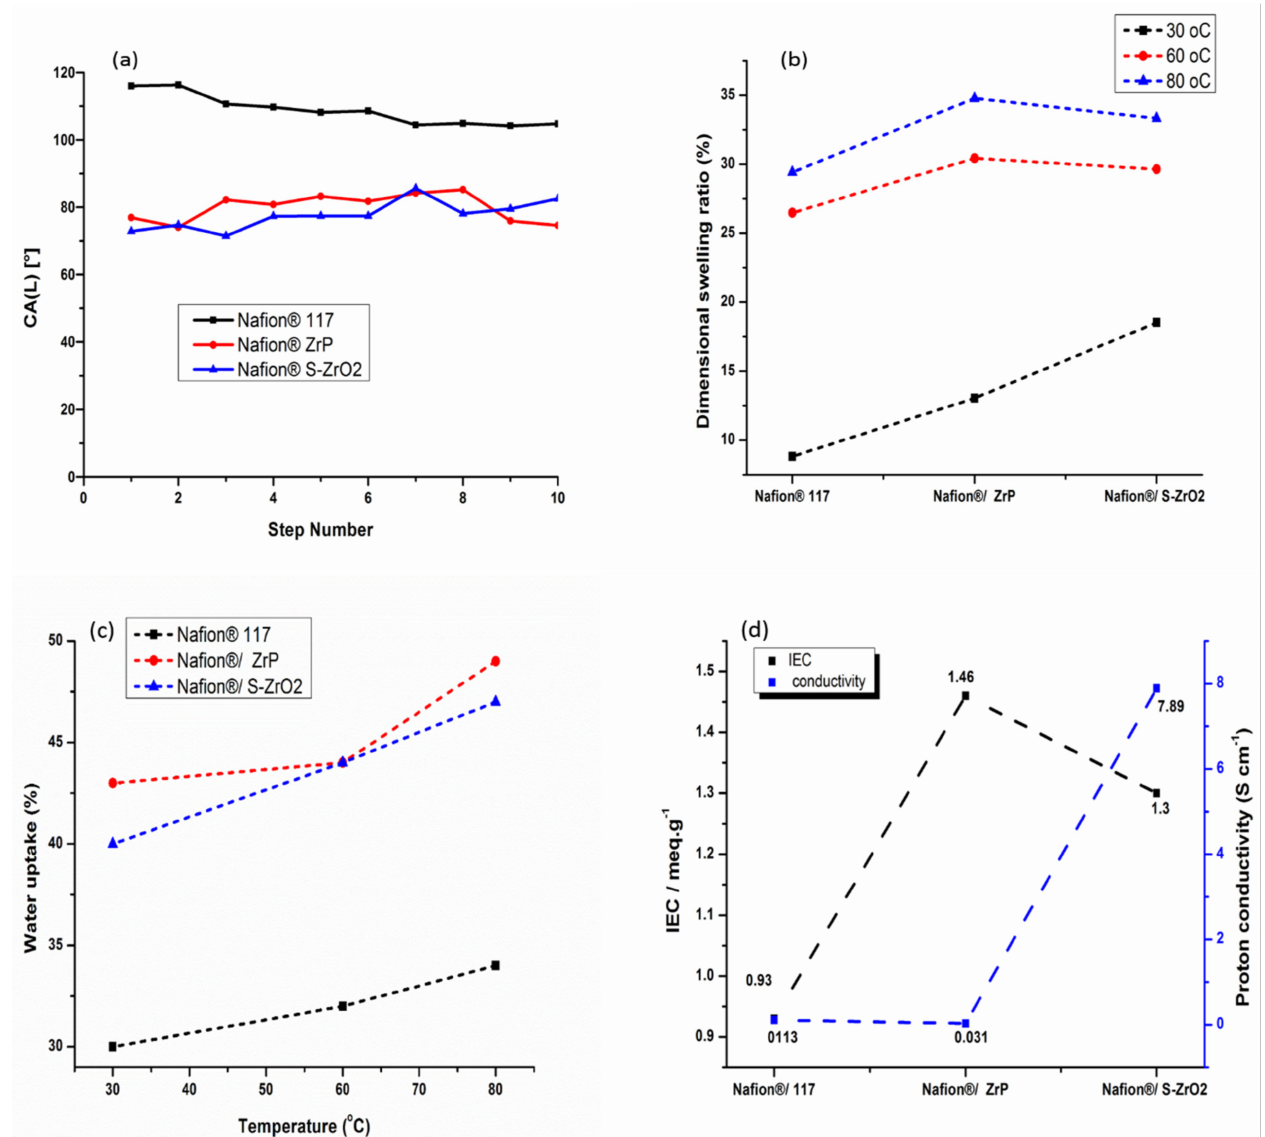
Figure 8. Contact angle ( a ), linear expansion ( b ), water uptake ( c ), and ion-exchange capacity and proton conductivity measurement ( d ) of Nafion ® 117 membrane, Nafion ® /ZrP and Nafion ® /S-ZrO 2 nanocomposite